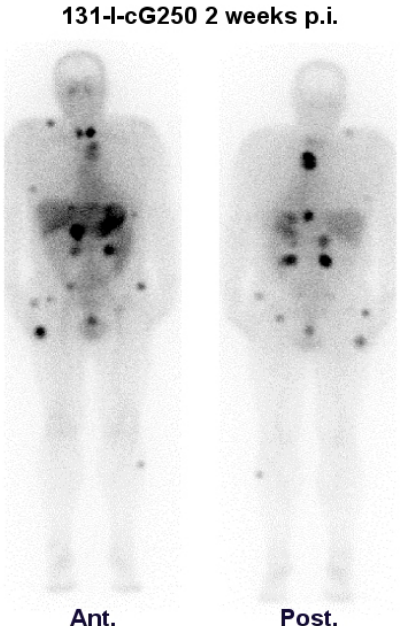
Figure 2. Whole body scan of a patient with multiple RCC metastases two weeks after infusion of 4144 MBq 131 I-cG250. Ant .: Anterior view; Post .: Posterior view.